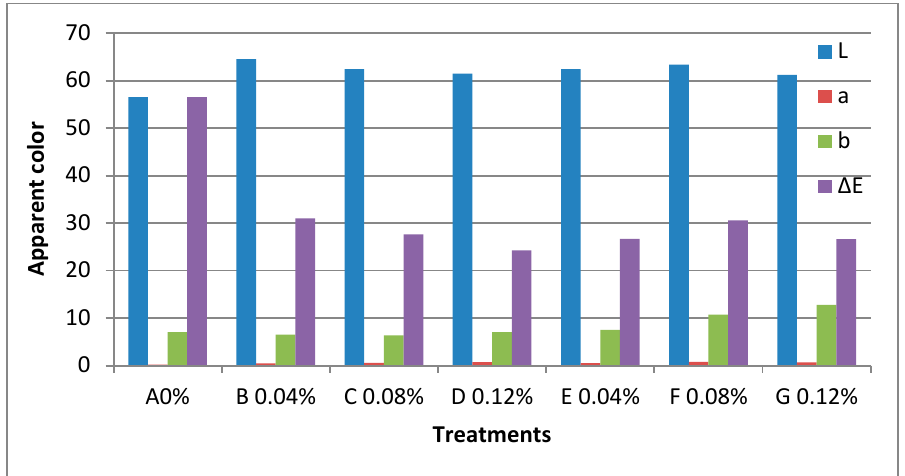
Figure 6. Measured of apparent color (Minolta Chroma) of the edible films prepared nano edible coating & films solution combined with ZnONPs and ZnONPs/PPE on edible films at different treatments A 0%, B 0.04%, C 0.08%, D 0.12%, E 0.04%, F 0.08% and G 0.12%.